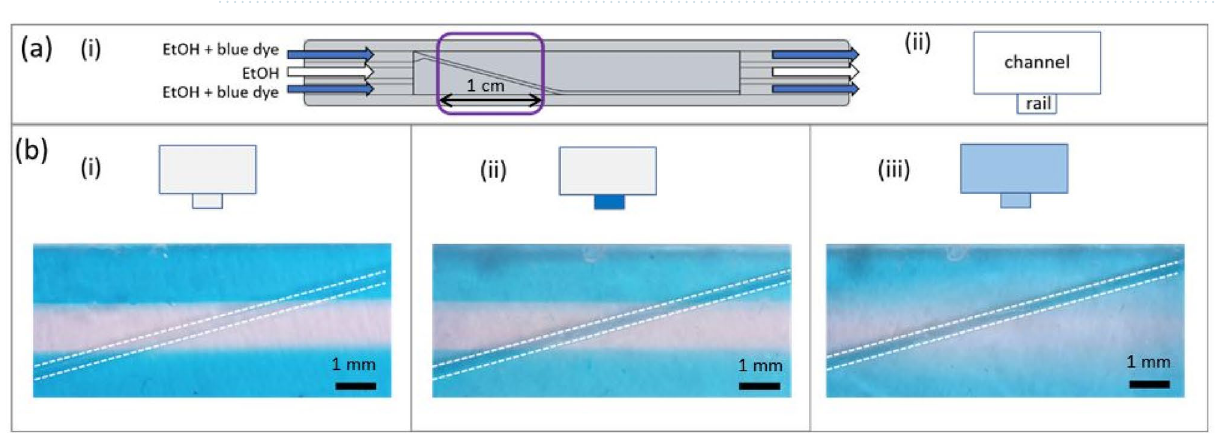
Figure 2. Profilometer measurement of the rail depth before bonding the parts of the chip: ( a ) 3D view, ( b ) line profile.